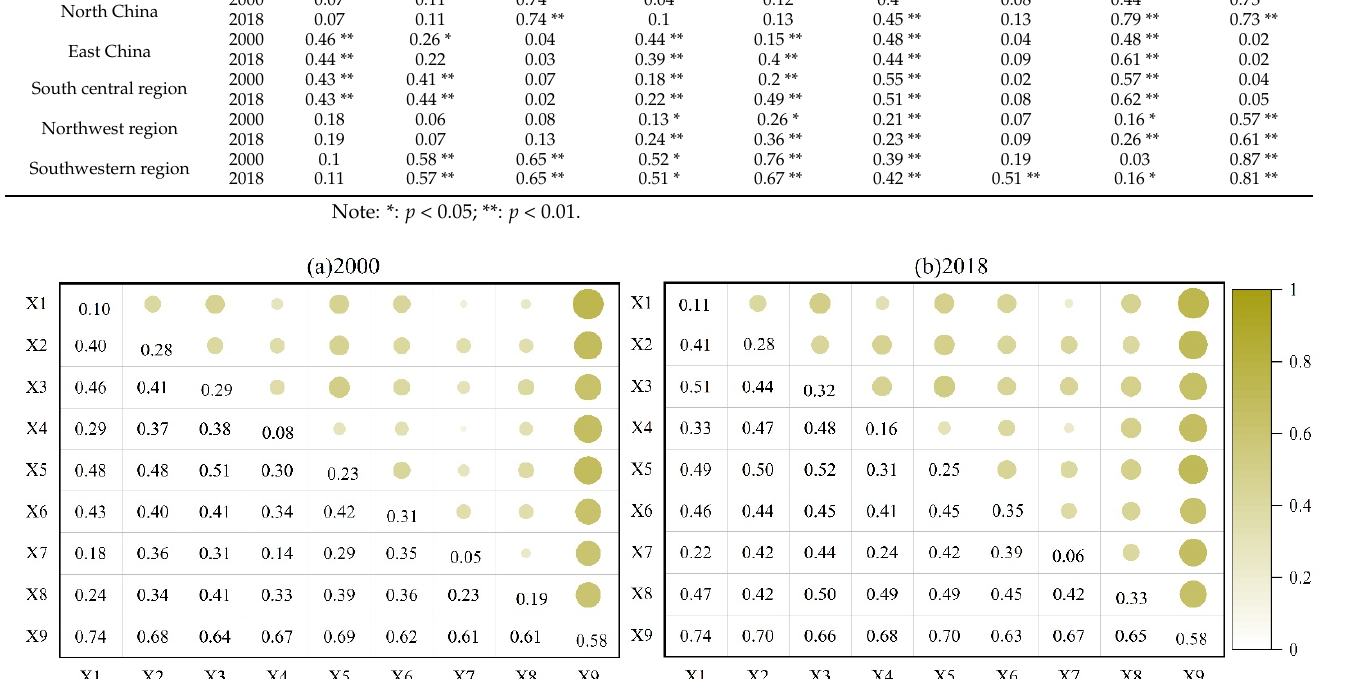
Figure 8. Result of driving factor interaction detection in a national scale in 2000 and 2018. Table 6. Dominant interactions between two variables in different regions.